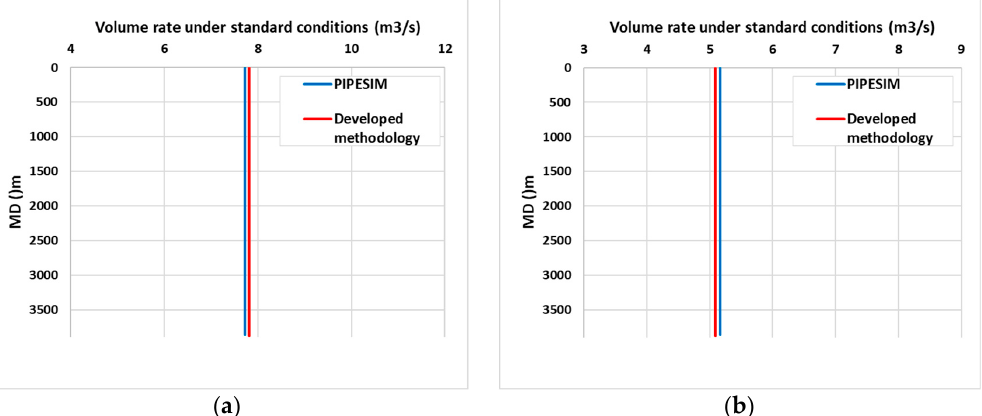
Figure 10. Volume gas flow rate distribution (standard condition) along the wellbore. The blue line represents the result of PIPESIM calculation, while the red line represents the result of calculation of the proposed model. The black oil model is ( a ), while the compositional model is ( b ). In addition to the above parameters, the proposed method allows calculating the pa- rameters of density, velocity, volume fraction, and viscosity of each phase (liquid, water, gas), as well as the mass, density, and inner radius of the layer of paraffin formed at any time.